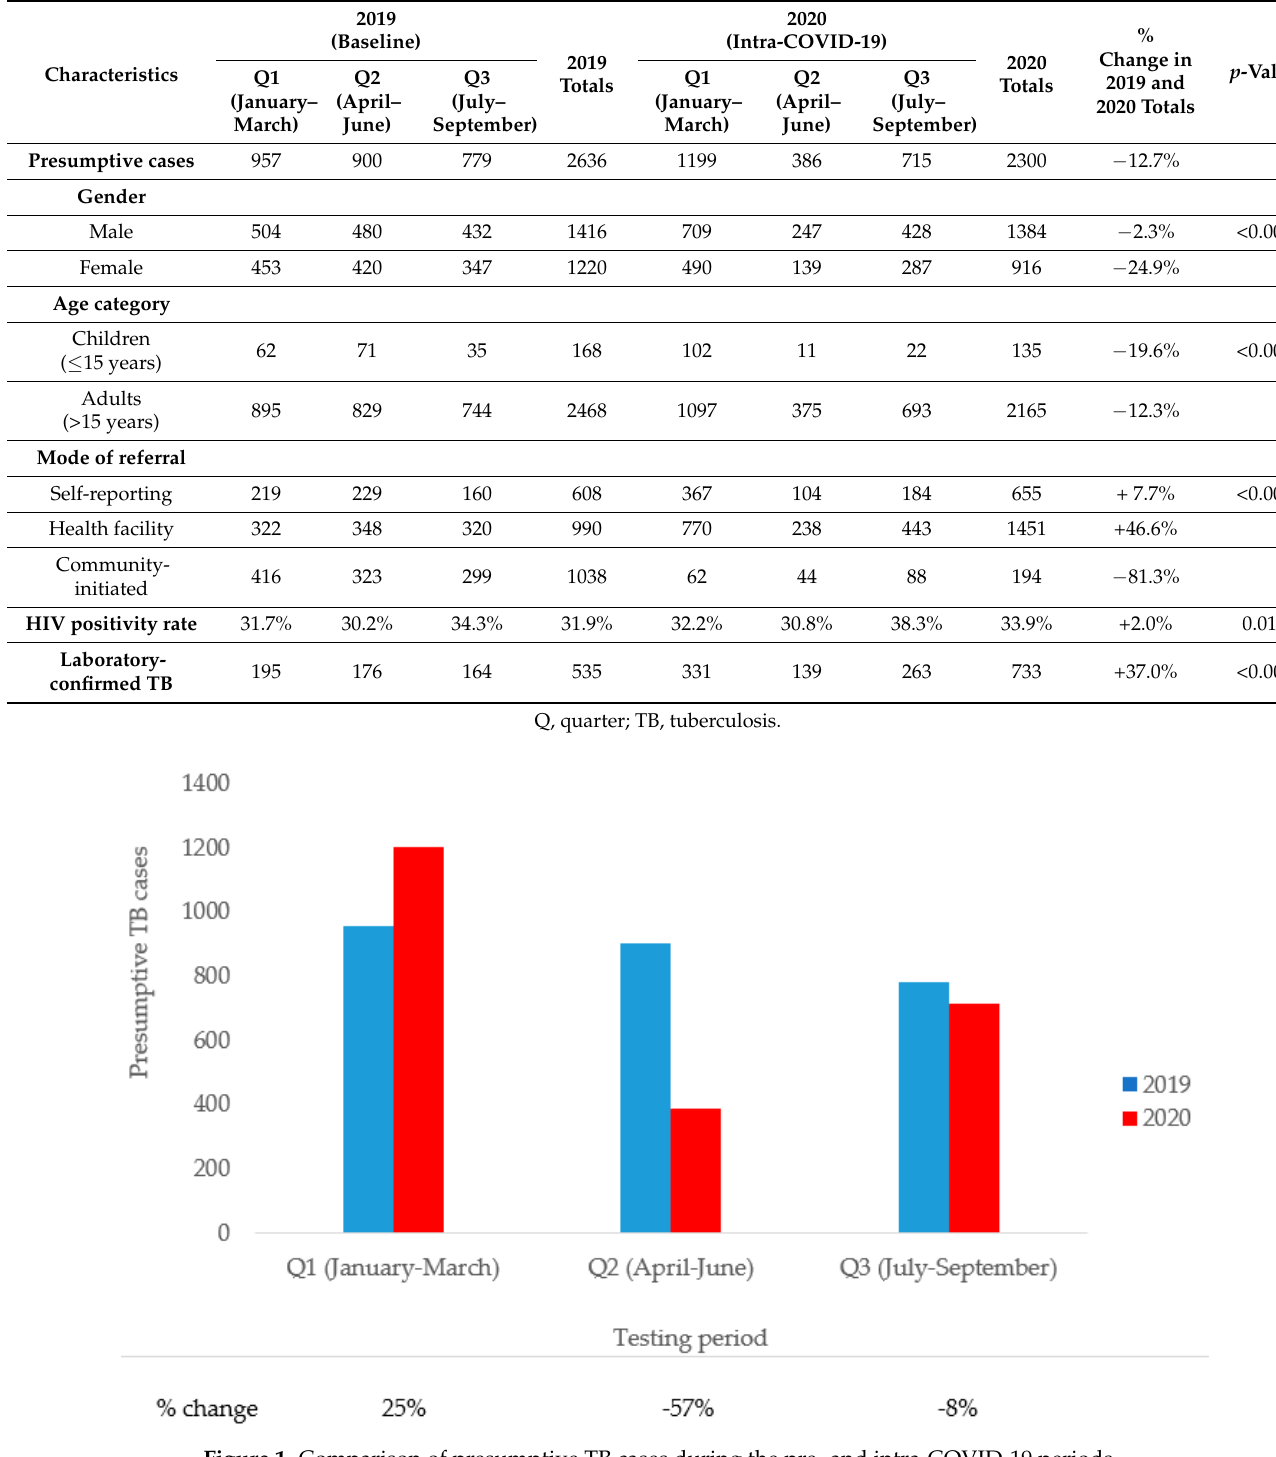
Figure 1. Comparison of presumptive TB cases during the pre- and intra-COVID-19 periods. Trends in monthly referrals and laboratory-confirmed TB cases during Q1–Q3 of 2019 and 2020, respectively, are shown in Figure 2. There were more TB referrals during